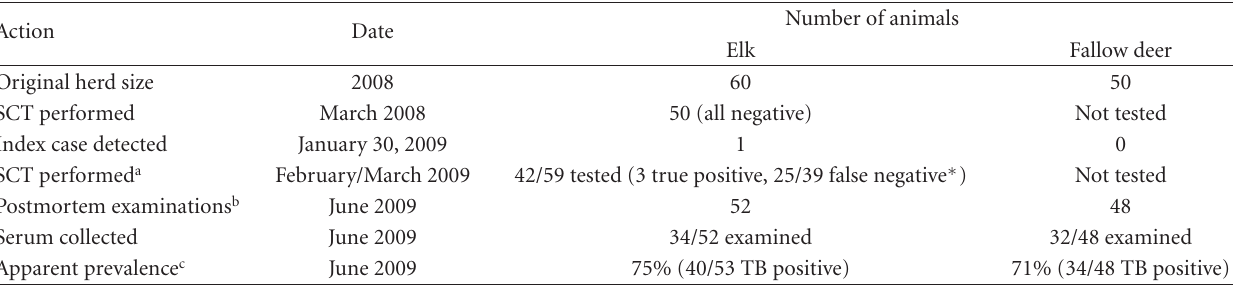
Table 1: History of herd and timeline of the outbreak